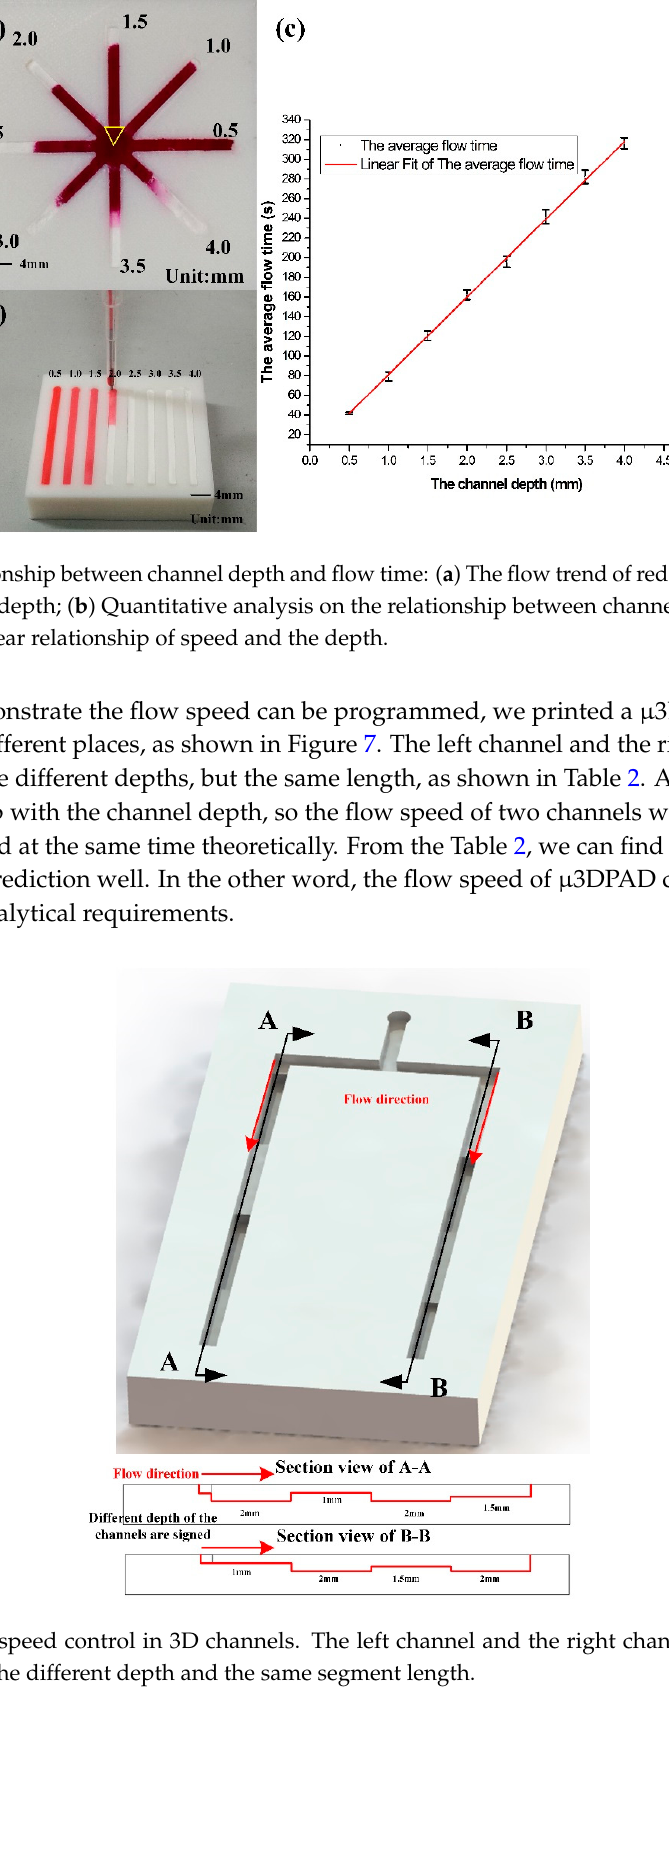
segments with the different depth and the same segment length.